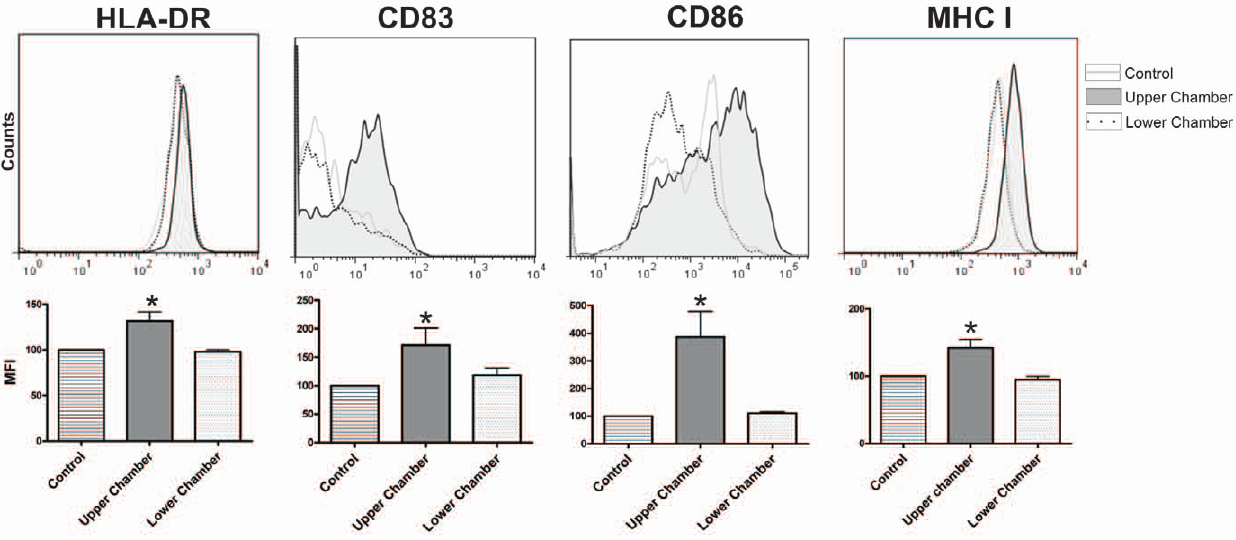
Figure 2. Epithelial cells induce the phenotypic maturation of pDCs in a cell contact-dependent manner. Experiments were performed using 24-transwell chambers with a polycarbonate filter (0.2 m m pore size). HT-29 cells were grown to confluence on the filter. pDCs (3 6 10 5 ) were cultured alone in the lower chamber or in contact with the monolayer of epithelial cells, in the upper chamber. Control cells were cultured in the upper chamber without epithelial cells. After 12 h of culture, pDCs were harvested and the expression of HLA-DR, CD83, CD86, and MHC class I was analyzed in the gate of CD123 + cells by flow cytometry. The relative mean fluorescence intensity (MFI) of isotype controls were in all cases lower than 5 (not shown). The MFI for control cells (for all the markers analyzed) was assigned to the value of 100, and the MFI for pDCs cultured alone in the lower chamber (X) or those cultured in contact with the monolayer of epithelial cells in the upper chamber (Y) was calculated using the equation: X or Y 6 100/MFI of control pDCs. Histograms show a representative experiment (n=4–8). Graph bars show the MFI of HLA-DR, CD83, CD86, and MHC class I in the gate of CD123 + cells. Results are the mean 6 SEM of 6–7 experiments. (* p , 0.05 vs control).